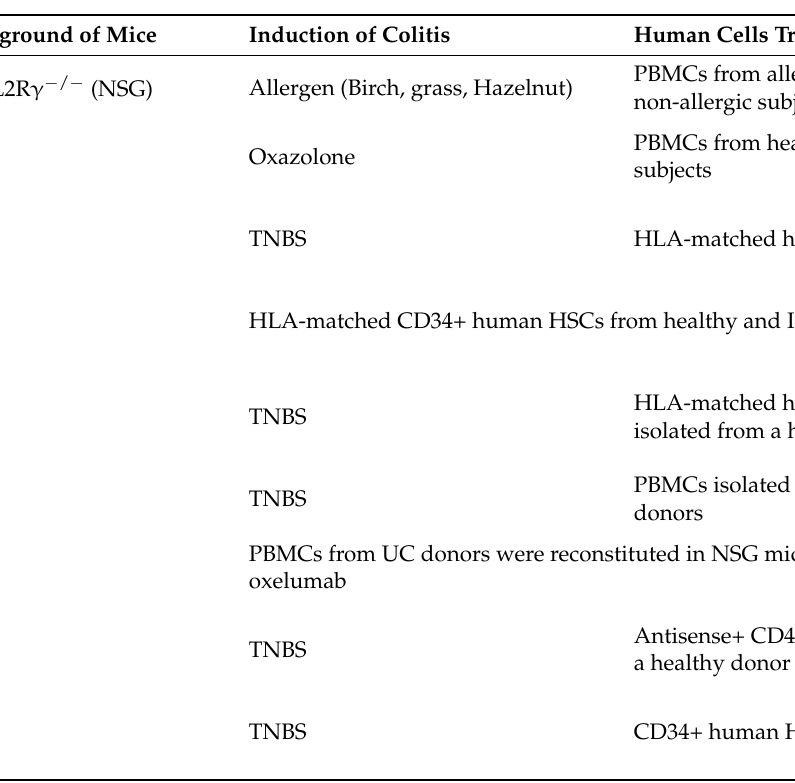
Table 2. Developed humanized mouse models to study IBD